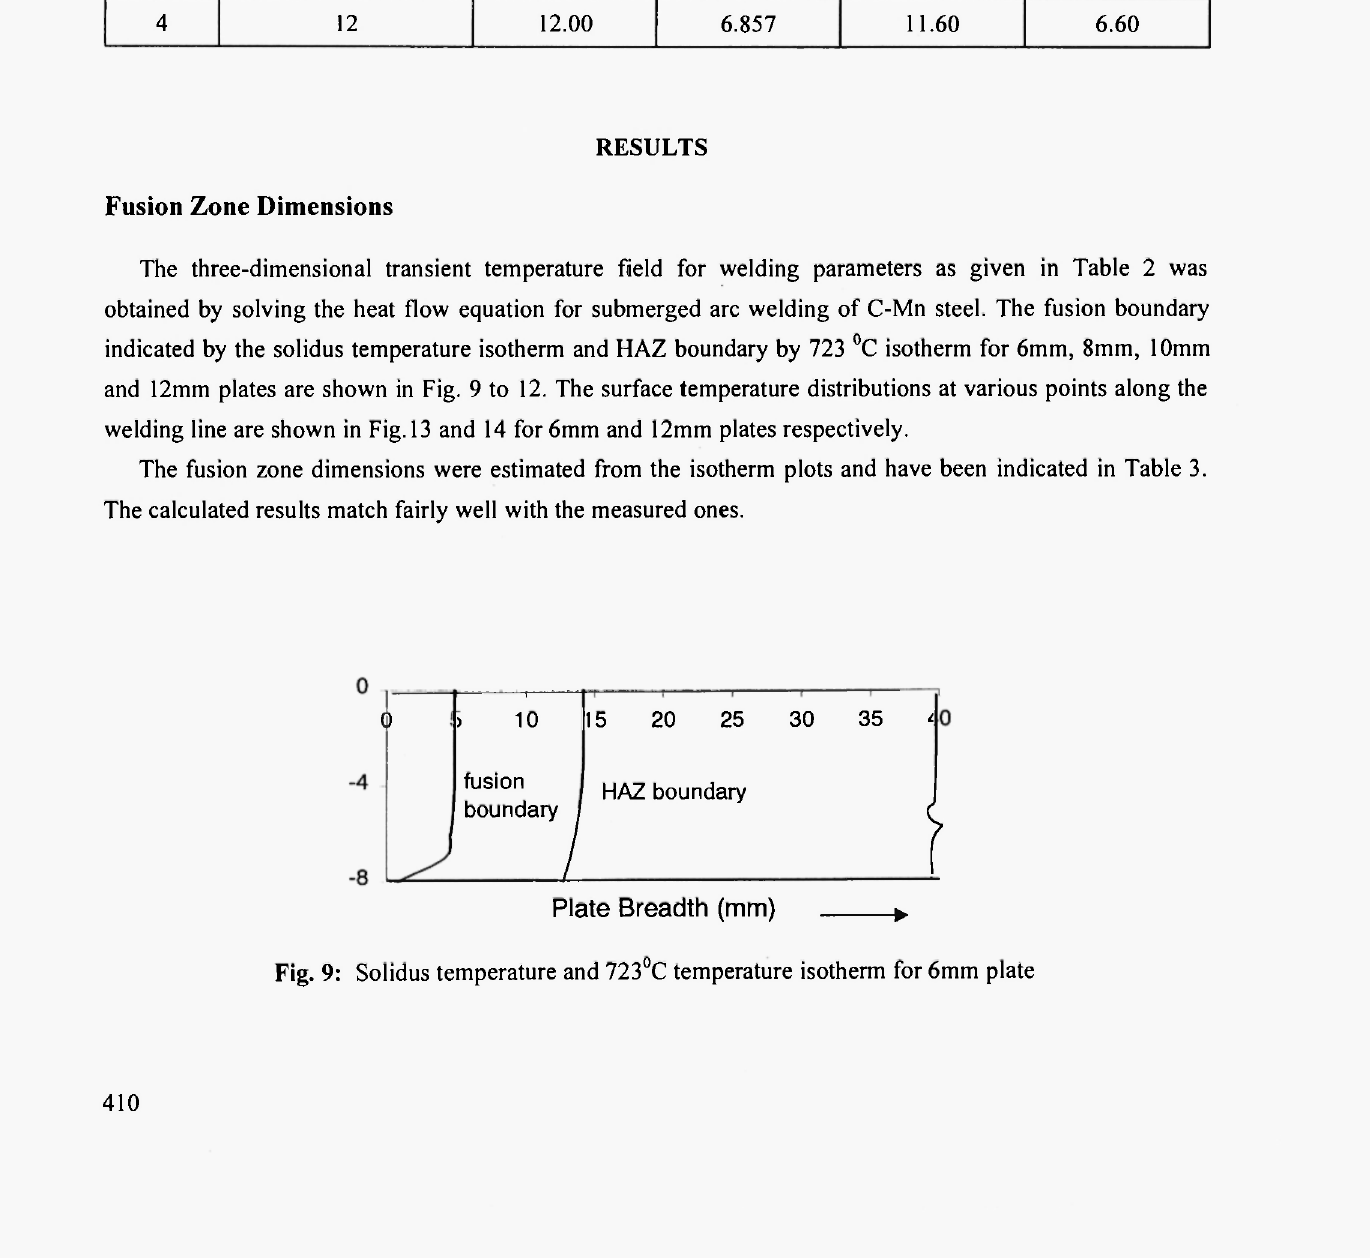
Fig. 9: Solidus temperature and 723°C temperature isotherm for 6mm